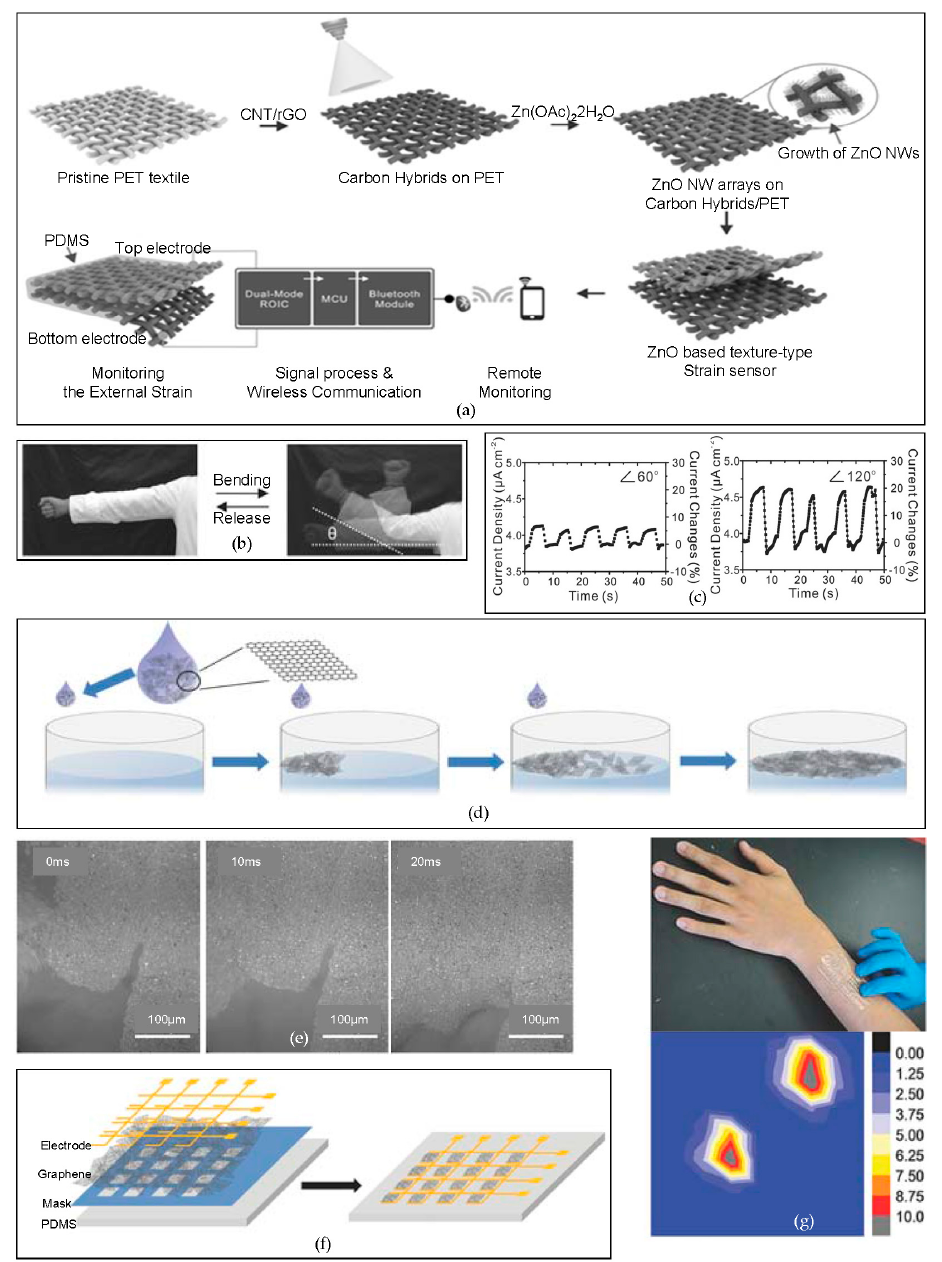
Figure 7. Flexible textile sensor based on a hybrid of carbon materials as the substrate/Strain sensors based on ultrathin graphene films. ( a ) A schematic of the fabrication of a flexible textile strain sensor generated via the growth of ZnO nanowires; ( b , c ) The bending and releasing of the cloth made by a flexible textile strain sensor and the corresponding results according to the different bending angles of the arm; Reproduced with permission from 2016 Advanced Functional Materials [83]; ( d ) Graphene flakes forming the ultrathin graphene film (UGF) via the π - π interactions among each other; ( e ) Optical images of the formation of UGF taken in 20 ms by a high-speed charge-coupled device (CCD) camera; ( f ) A schematic of a strain sensor fabricated from the self-assembled UGF; ( g ) A strain sensor applied on the forearm and the real-time response map of pressure applied on the strain sensor. Reproduced with permission from 2016 Advanced Materials